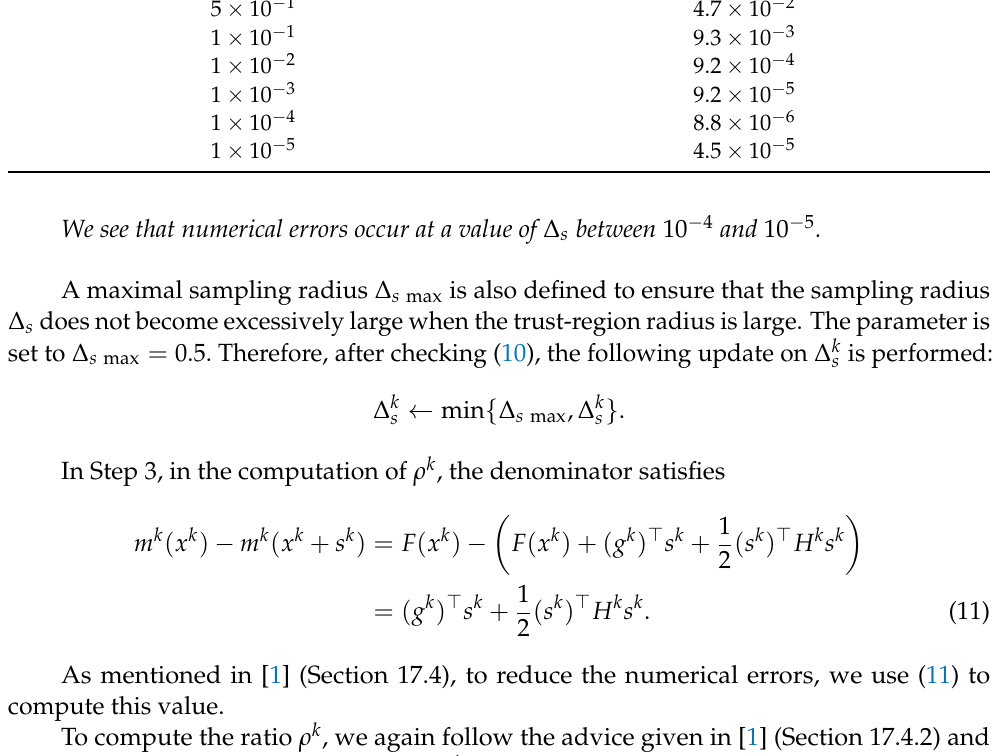
Table 1. Relative error of the simplex Hessian ∇ 2 s F ( x 0 ; S , T ) for different values of h . ∆